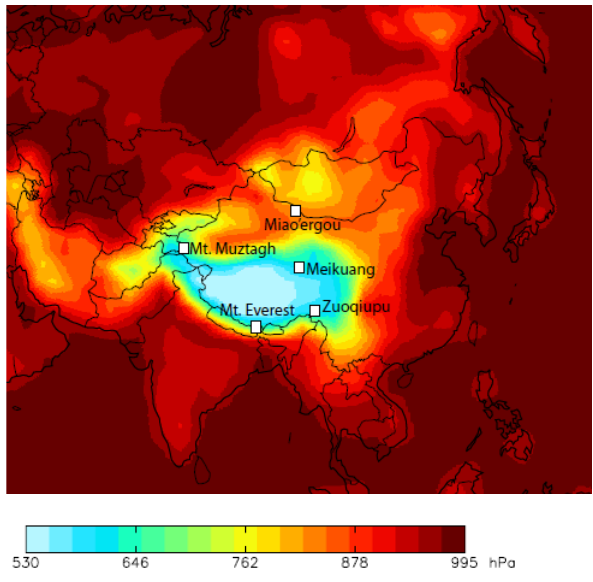
Figure 1. Location of the five glacier sites in the Himalayas and the Tibetan Plateau that we use Fig. 1. Location of the five glacier sites in the Himalayas and the as receptors in this study. Annual mean surface pressure from GEOS-Chem is overlaid. We Tibetan Plateau that we use as receptors in this study. Annual mean compare measured concentrations of BC in snow at these sites with concentrations simulated by surface pressure from GEOS-Chem is overlaid. We compare mea- GEOS-Chem. sured concentrations of BC in snow at these sites with concentra- tions simulated by